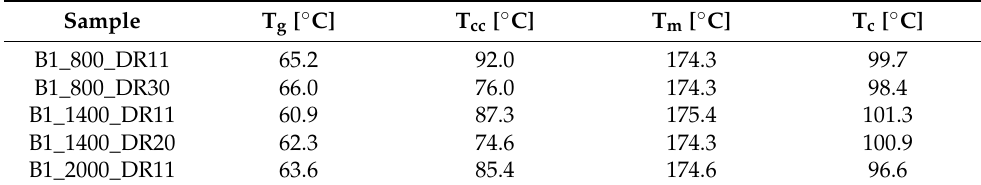
Table 4. Differential scanning calorimetry data for Figure 7.